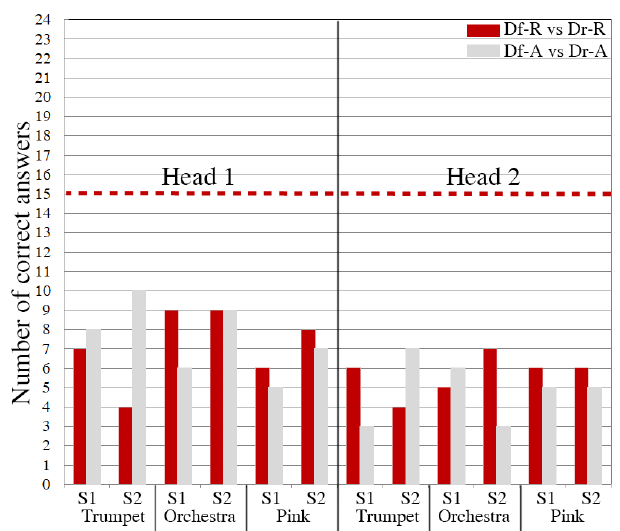
Figure 10. Listening test results. The dashed horizontal line indicates the minimum number of correct answers necessary to indicate a significant perceptual difference between configurations compared in one pair. x -axis indicates the pairs compared in each trial.